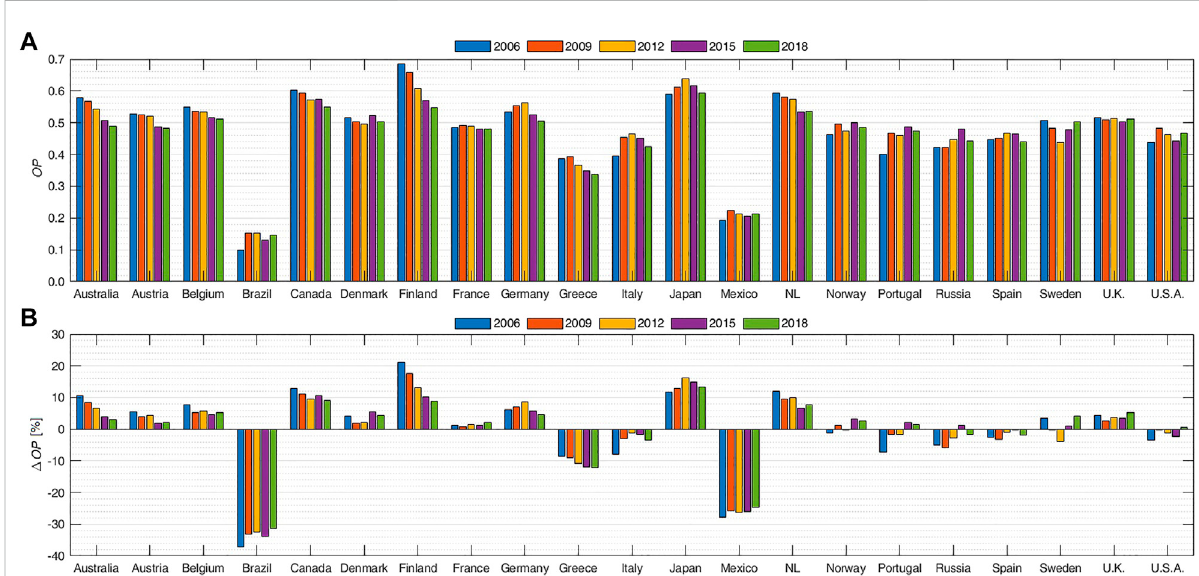
FIGURE 1 (A) Values of the arithmetic mean of the normalized OECD ’ s PISA scores in Mathematics and Sciences ( OP ) in 2006, 2009, 2012, 2015, and 2018 for the following countries: Australia, Austria, Belgium, Brazil, Canada, Denmark, Finland, France, Germany, Greece, Italy, Japan, Mexico, the Netherlands (NL), Norway, Portugal, Russian Federation (Russia), Spain, Sweden, the United Kingdom (UK), and the United States of America (USA). The OECD ’ s PISA scores have been retrieved from the OECD ’ s database [43]. (B) Percentage variation for each of the aforementioned year and country from the annual OP mean value within the considered